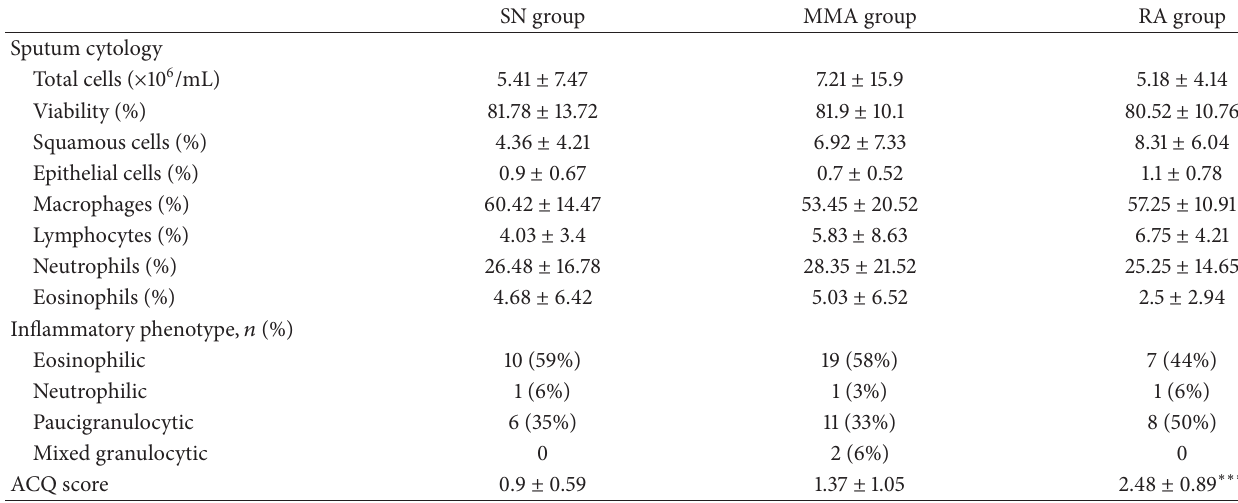
Table 3: The cellular profile of sputum, asthma phenotypes, and ACQ score at visit 2. Values are presented as mean ±